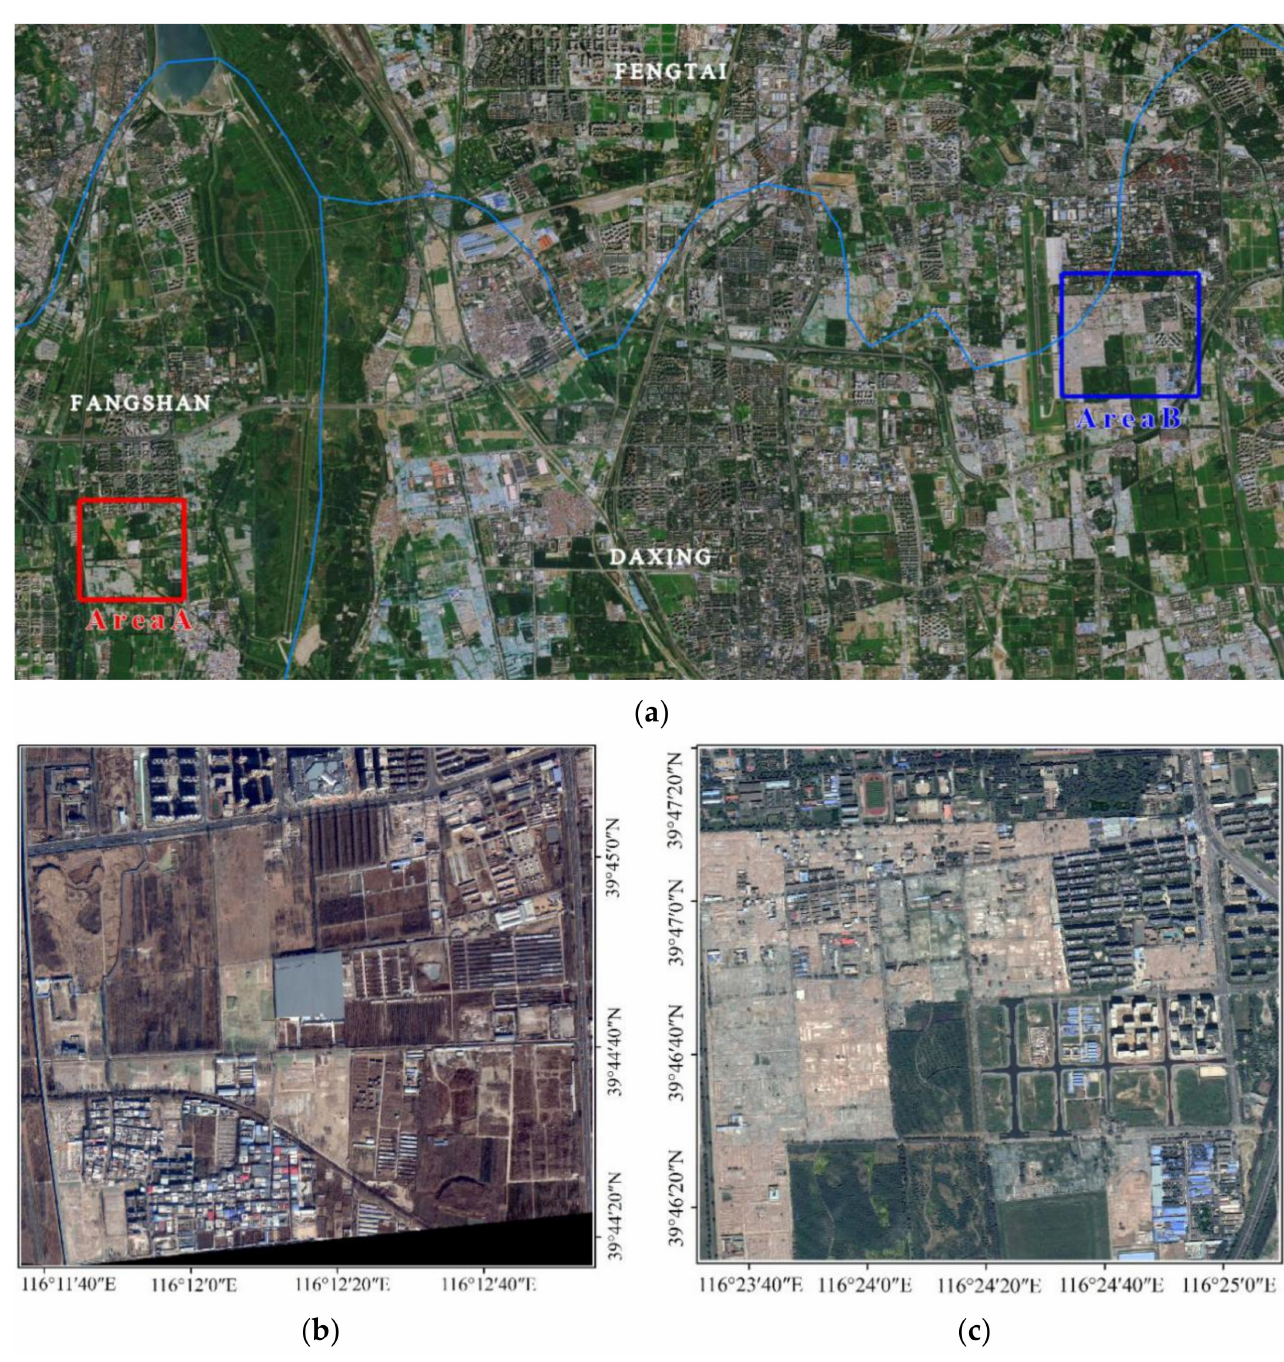
Figure 1. Study area and material. ( a ) The whole study area; ( b ) study area A (WV2,2017/12/20); ( c ) study area B